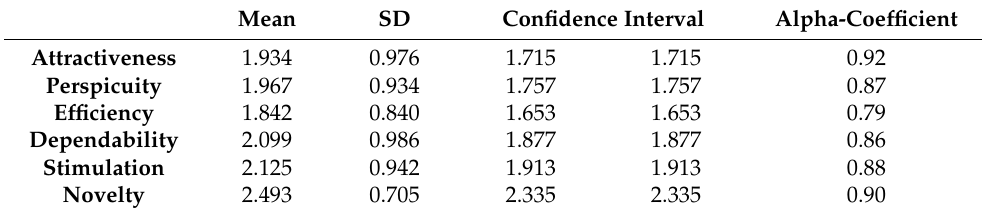
Table 4. Scores of the six UEQ